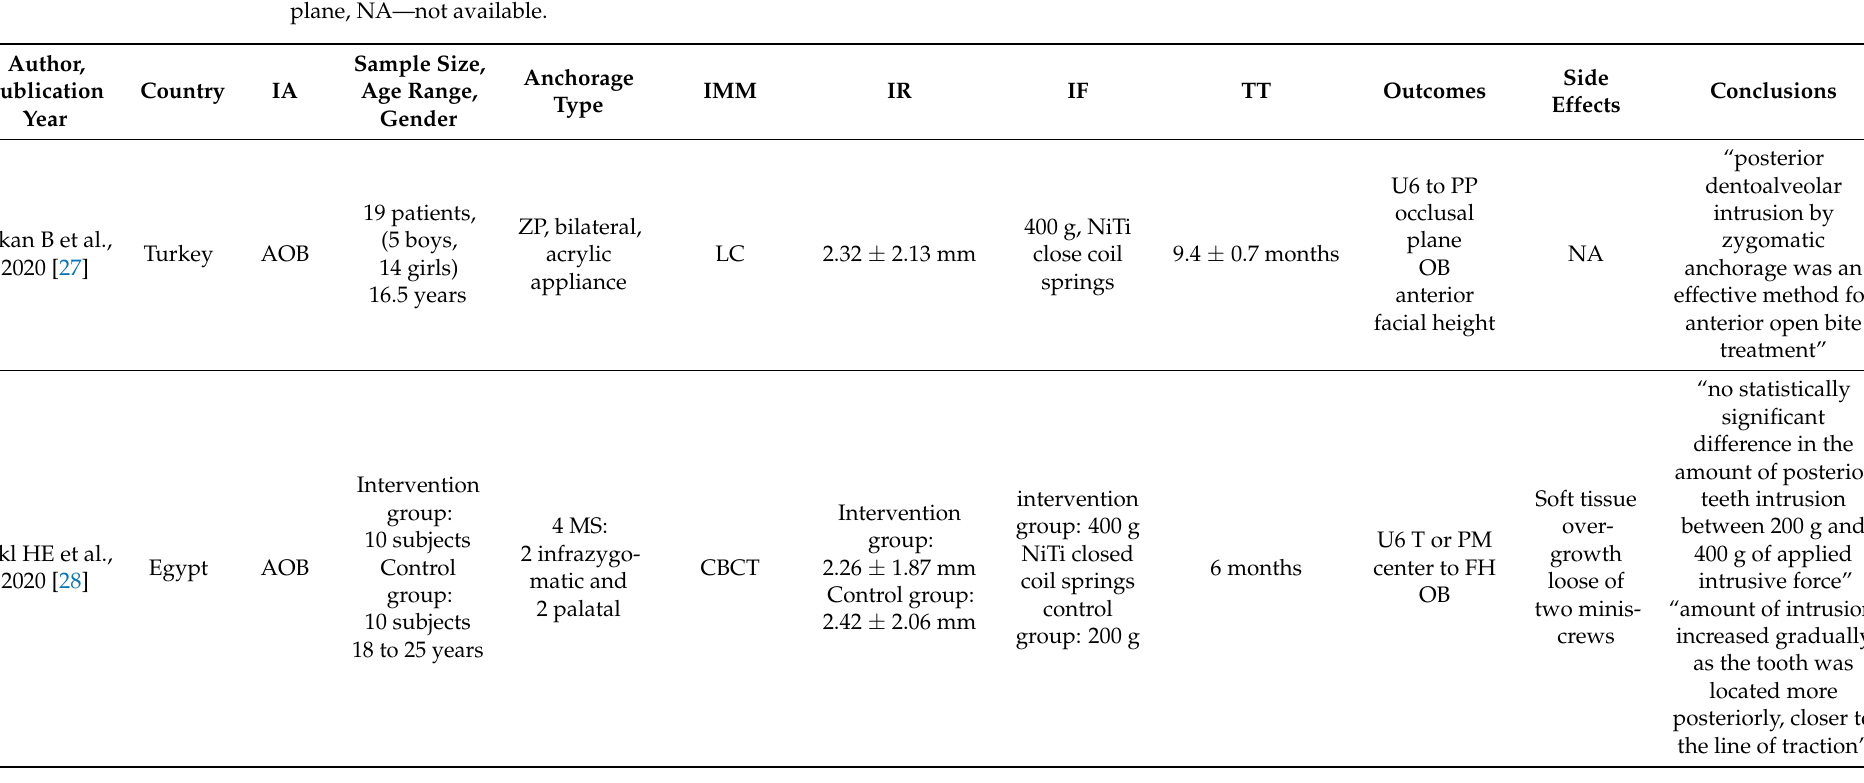
Table 1. Characteristics of the reviewed studies. Abbreviations are as defined as follows: IA—intrusion aim; IMM—intrusion measurement method; IR—Intrusion range; IF—intrusion force; TT—treatment time; OVE—overerupted; AOB—anterior open bite; MS—miniscrew, ZP—zygomatic plate, LC—lateral cephalogram, PAR—postero-anterior radiographs; PR—panoramic radiograph, CBCT—cone-beam computed tomography, NiTi—nickel-titanium; U6—upper first molar, PP—palatal plane; OB—overbite; FH—Frankfurt horizontal plane; T—trifurcation; PM—premolar; EARR—external apical root resorption; SN—sella to nasion plane, NA—not